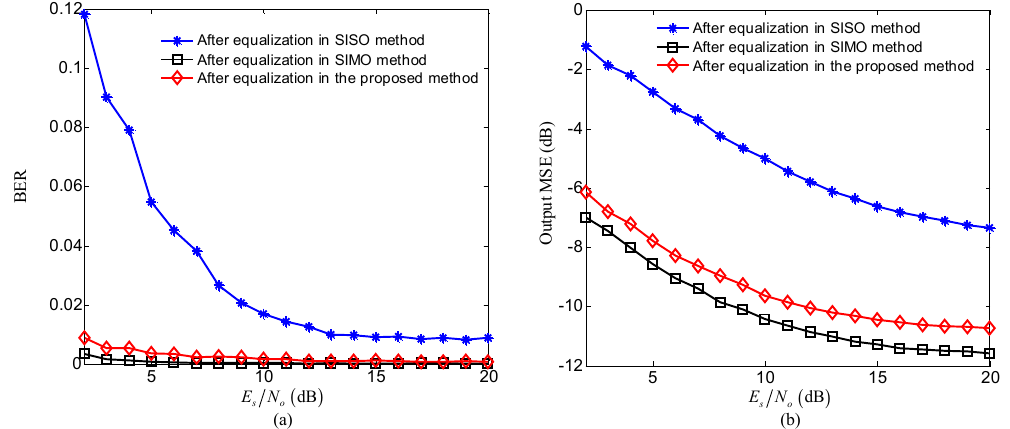
Figure 8. Comparison of the performance after equalization among three methods including of the proposed method, SISO method and SIMO method: ( a ) BER; ( b ) output MSE.